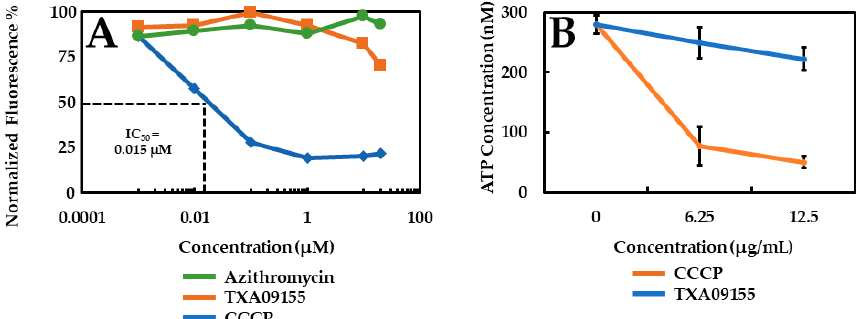
Figure 4. ( A ) TXA09155 did not depolarize the inner membrane of P. aeruginosa , which was determined by the DiOC 2 (3) membrane polarization assay. ( B ) TXA09155 treatment of P. aeruginosa did not result in ATP depletion. Experiments were repeated at least three times; a representative experiment is shown in ( A ), and values represent mean ± S.D. in ( B